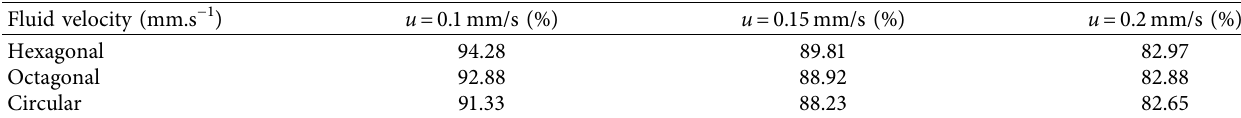
Table 3: Mixing efficiency at f � 15Hz and φ � π